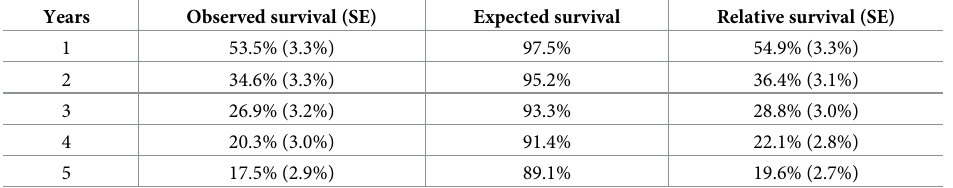
Table 3. Observed, expected and relative survival rates of pancreatic acinar cell carcinoma patients from 2004 to